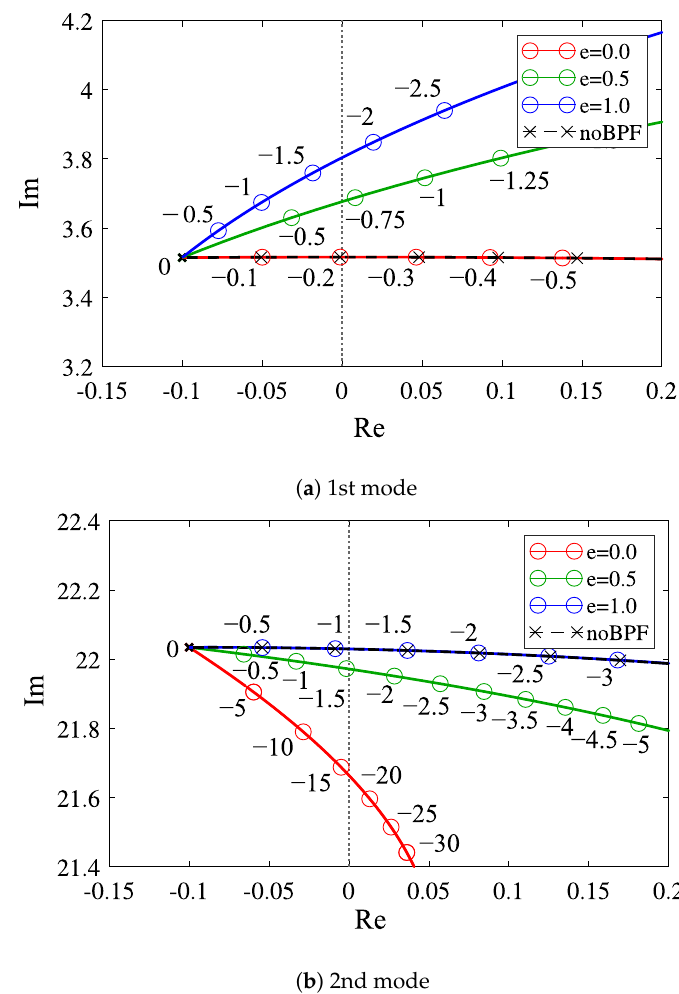
Figure 4. Dependency of the root locus with respect to the feedback gain α ∗ on the center frequency of the band-pass filter; the number denotes the value of the feedback gain: ( a ) first mode; ( b ) second mode. Table 1. Parameter values used in the root loci of Figure